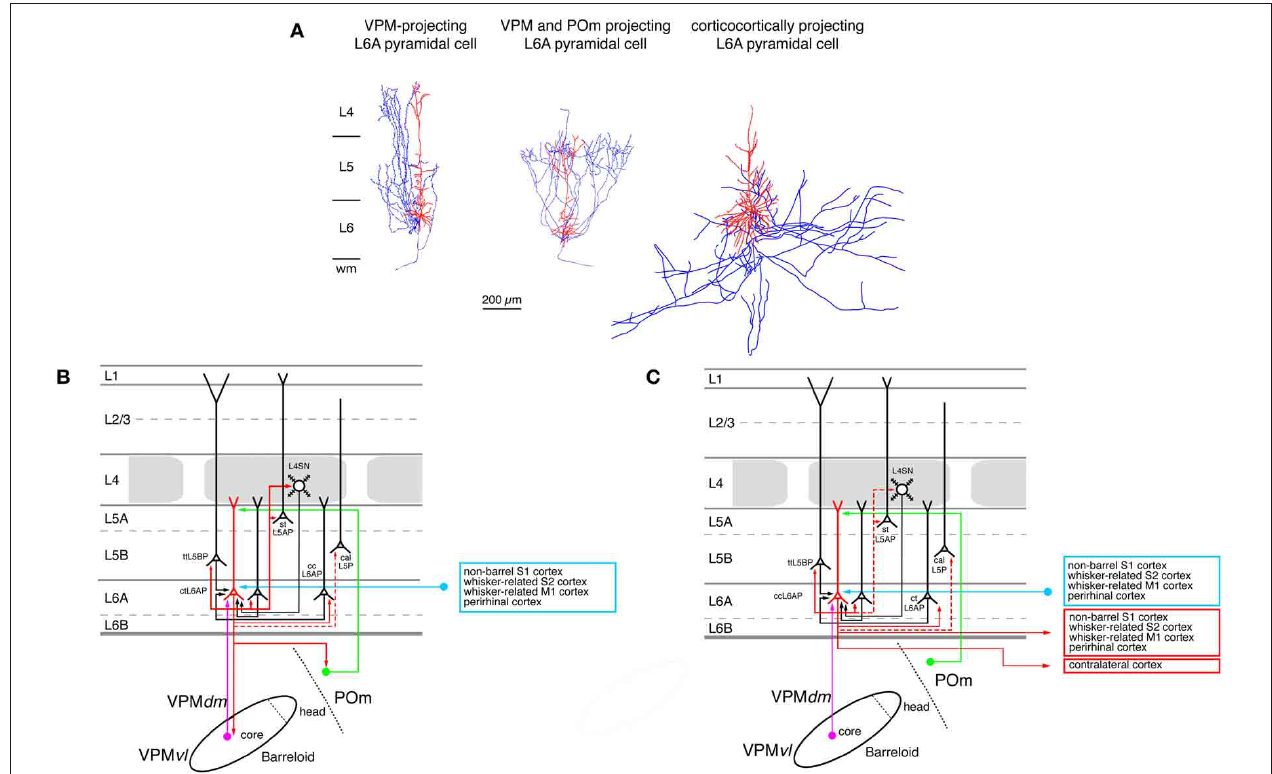
FIGURE 7 | Excitatory synaptic input–output relationship in layer 6 of the S1 barrel cortex. (A) Reconstructions of three types of pyramidal cells in sublamina A of layer 6 in the rat barrel cortex (Zhang and Deschênes, 1997); modiefied with permission of the Society for Neuroscience. L6A pyramidal cell projecting exclusively back to the VPM nucleus of the thalamus (left), L6A pyramidal neuron projecting to both the VPM and the POm nuclei of the somatosensory thalamus (middle) and a corticocortical L6A pyramidal cell. The apical trees of L6A pyramidal cells terminate between upper layer 5 and lower layer 3 and have very small or even no tuft. Modified with permission from the Society for Neuroscience. (B) Diagram of the excitatory synaptic connections of and onto corticothalamic L6A pyramidal cells (red neuron with